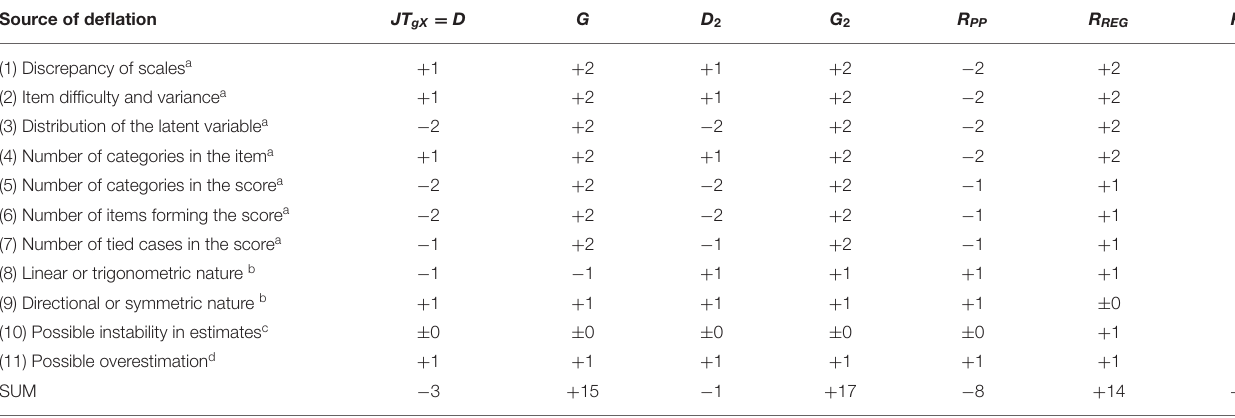
TABLE 6 | Sensitivity of the estimators of R RP to deflation (based on Metsämuuronen [29]). Source of